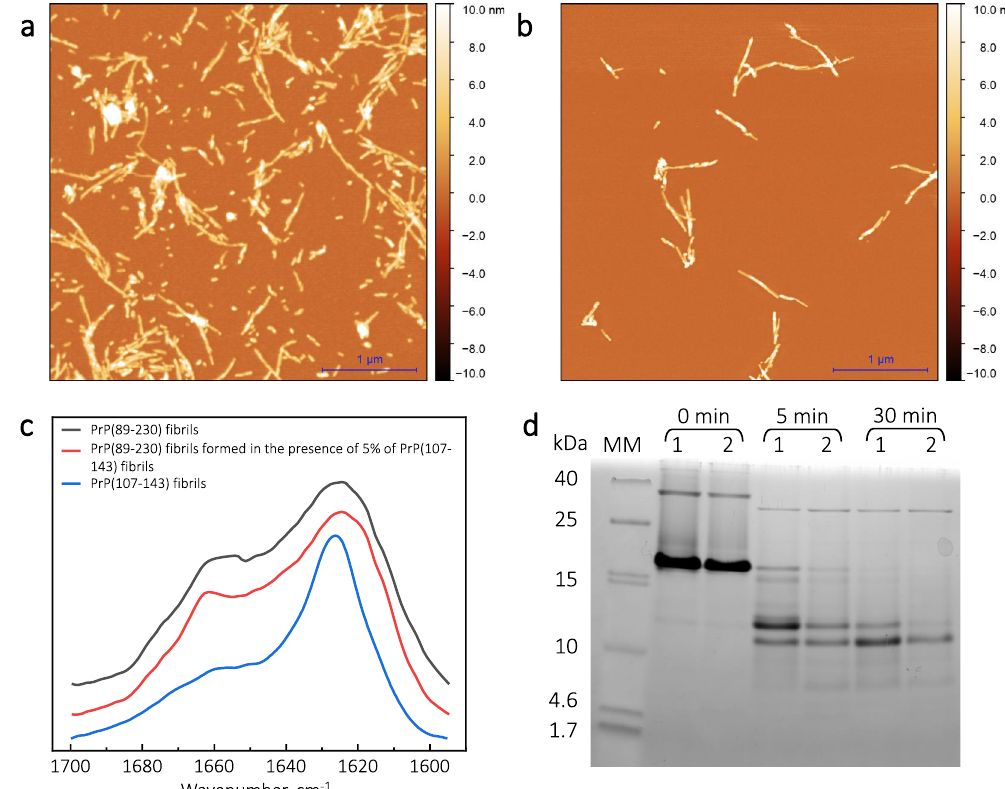
Figure A1. AFM images ( a , b ), FTIR spectra ( c ) and PK digestion SDS-PAGE ( d ) of PrP fibrils. ( a ) AFM image of PrP(89-230) fibrils. ( b ) AFM image of PrP(89-230) fibrils formed in the presence of 5%